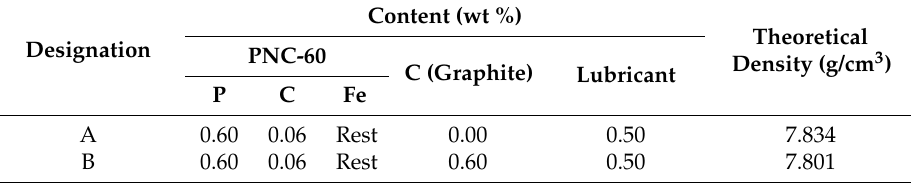
Table 2. Chemical composition of PNC-60 iron powder and of powder mixtures A and